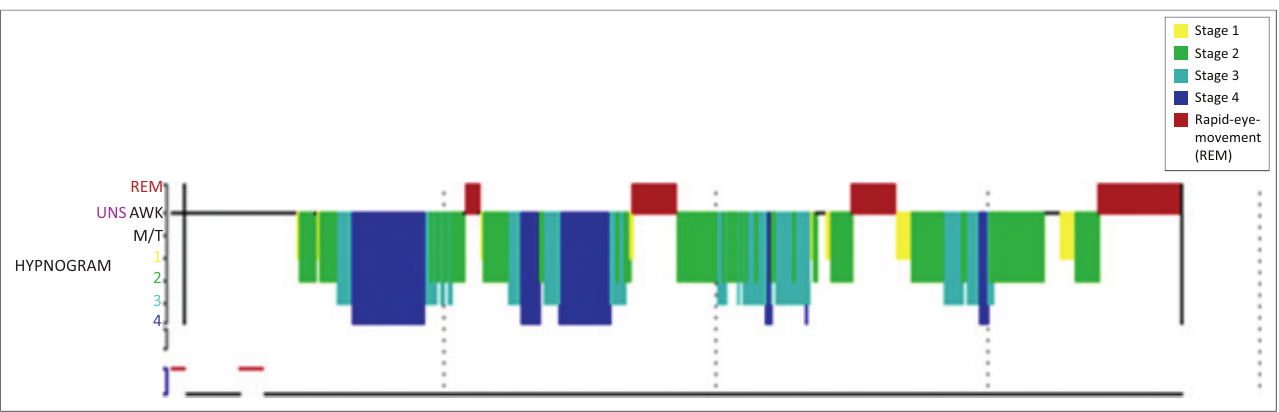
FIGURE 1: Adult hypnogram demonstrating the different sleep stages. The four stages of NREM sleep typically precede a period of REM